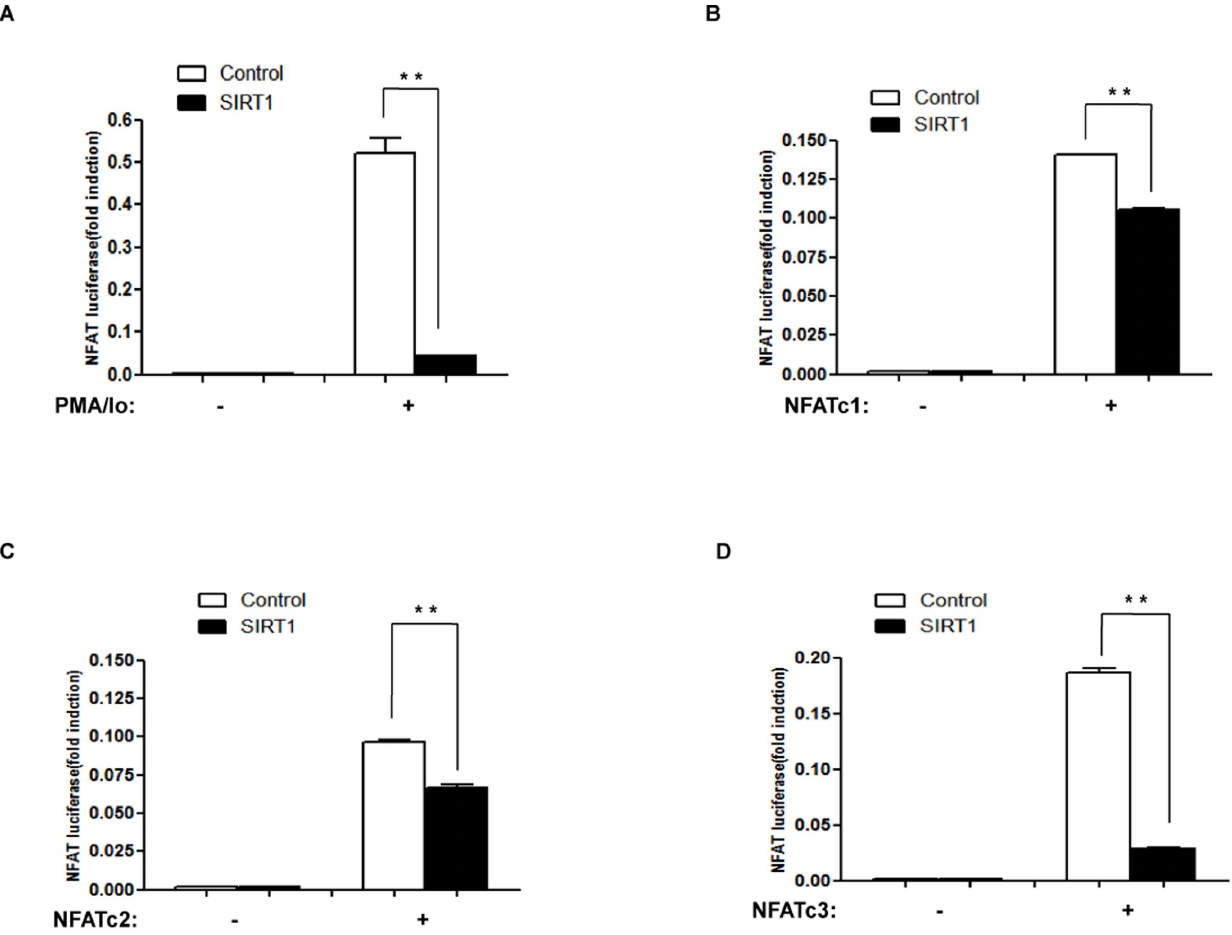
Figure 1. SIRT1 suppresses NFAT transcriptional activity. (A) HEK293 cells were transfected with 0.1 m g NFAT luciferase reporter (NFAT-luc), 30 ng pRL-TK, and 0.3 m g SIRT1 expression vector or control (pcDNA3.1) for 24 h and treated with PMA (10 ng/ml) and Io (0.25 m M) or vehicle for another 3 h. Luciferase activities are presented as the means 6 standard deviation (S.D.) of triplicate samples and are representative of three independent experiments. **, p # 0.01 versus control. (B–D) HEK293 cells were transfected with 0.1 m g NFAT luciferase reporter (NFAT-luc), 30 ng pRL- TK, 0.3 m g SIRT1 expression vectors or a control (pcDNA3.1), and 0.3 m g NFATc1 (B), or NFATc2 (C), or NFATc3 (D) expression vectors for 24 h. Luciferase activities are presented as the means 6 standard deviation (S.D.) of triplicate samples and are representative of three independent experiments. **, p # 0.01 versus control.